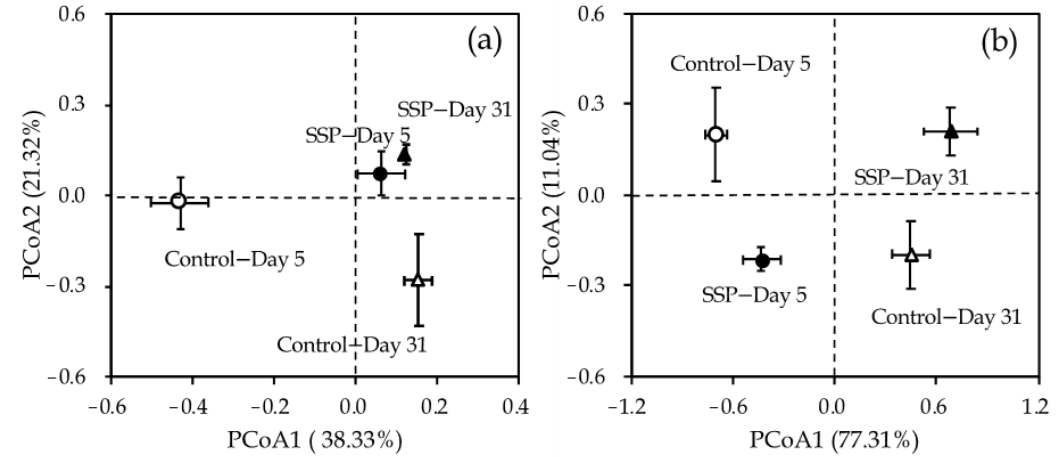
Figure 4. Methanogenic ( a ) and methanotrophic ( b ) community structures (based on relative OTU abundance) assessed by principal coordinate analysis (PCoA) based on the Bray–Curtis distance for different treatments. Treatments were defined as in Figure